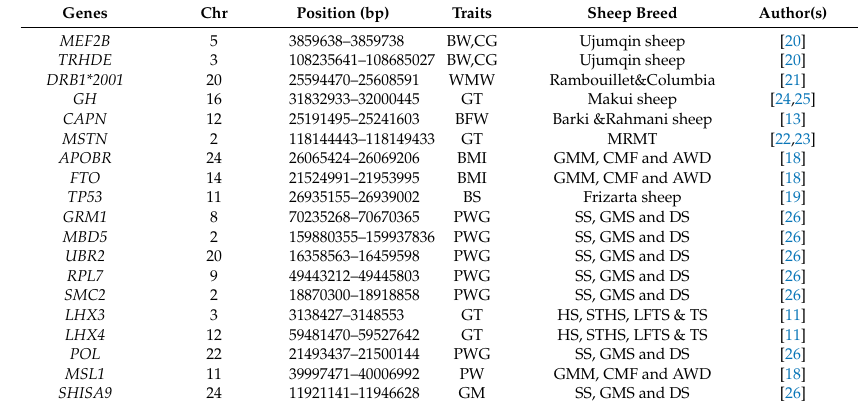
Table 1. Description and chromosomal location of candidate genes associated with body weight and growth